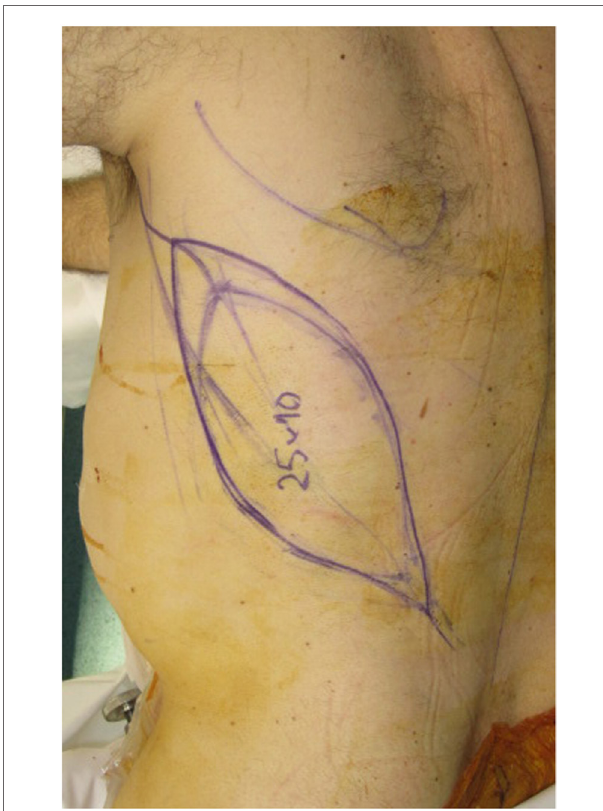
FigUre 5 | a free latissimus dorsi myocutaneous flap was selected for reconstruction of the defect, with donor site marked .